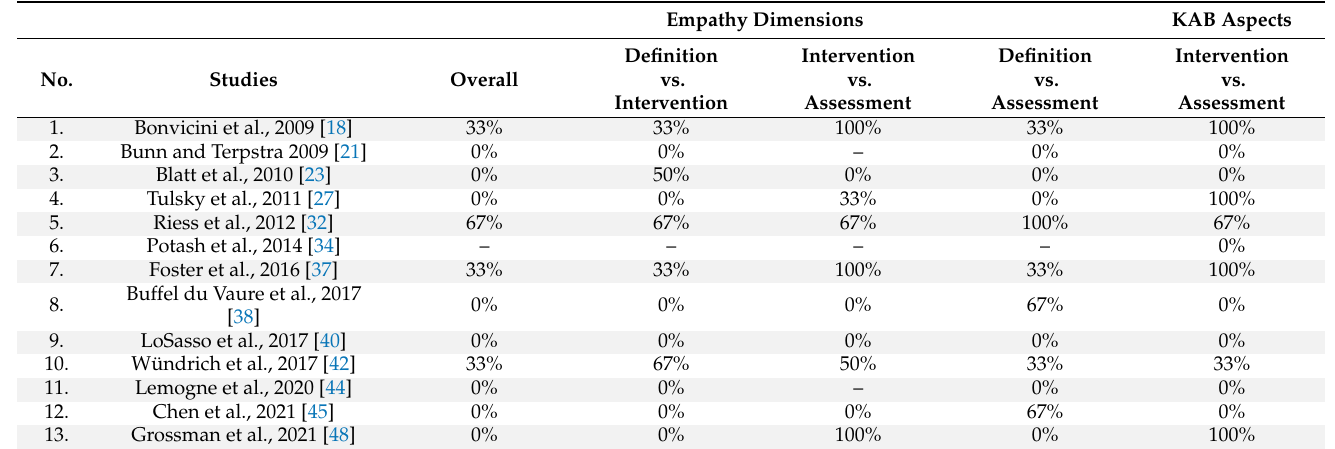
Table 2. Percentage of consistency in terms of empathy dimensions and knowledge–attitude–behavior (KAB) aspects among different sections of the medical empathy intervention studies. ( N =